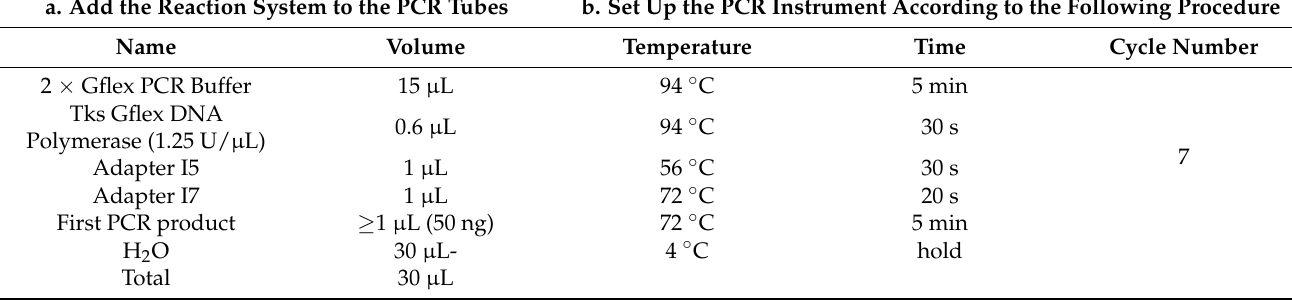
Table 8. Second Round PCR